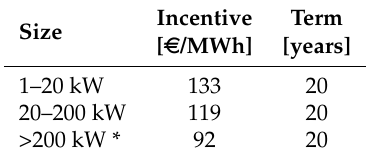
Table 6. Self-consumption tariffs for concentrating PV plants established in